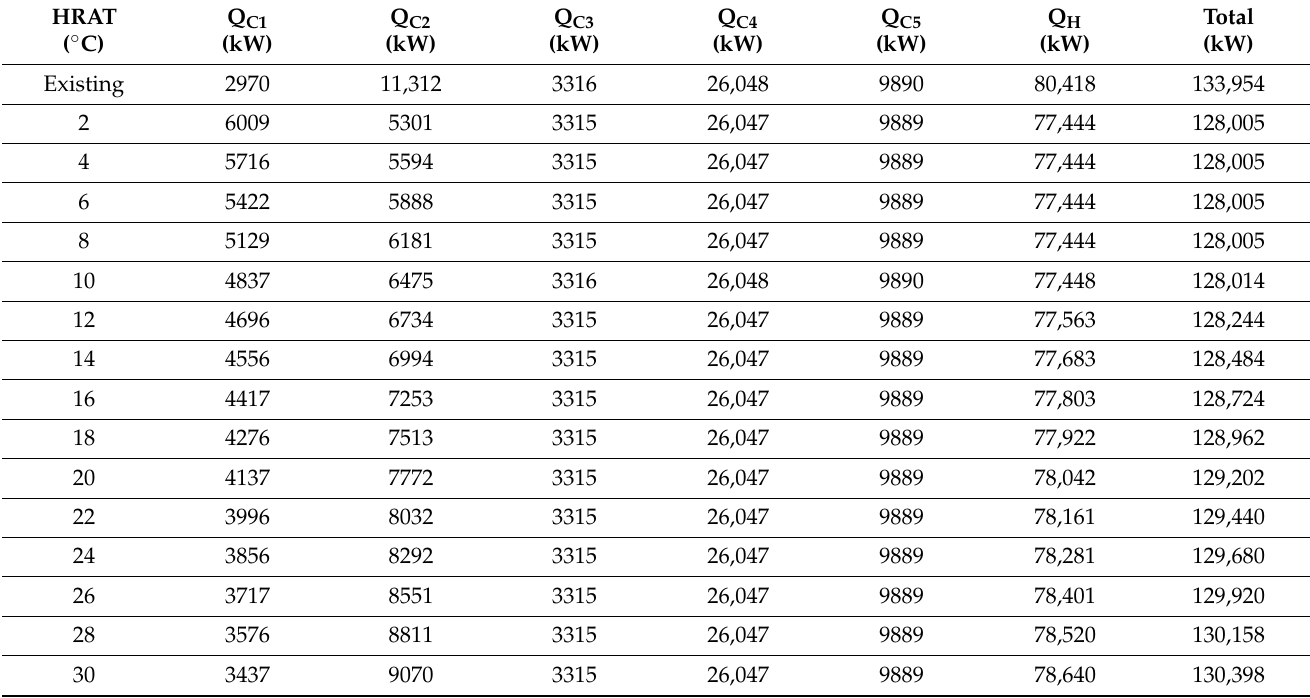
Table A10. External energy consumption at different HRAT values for option